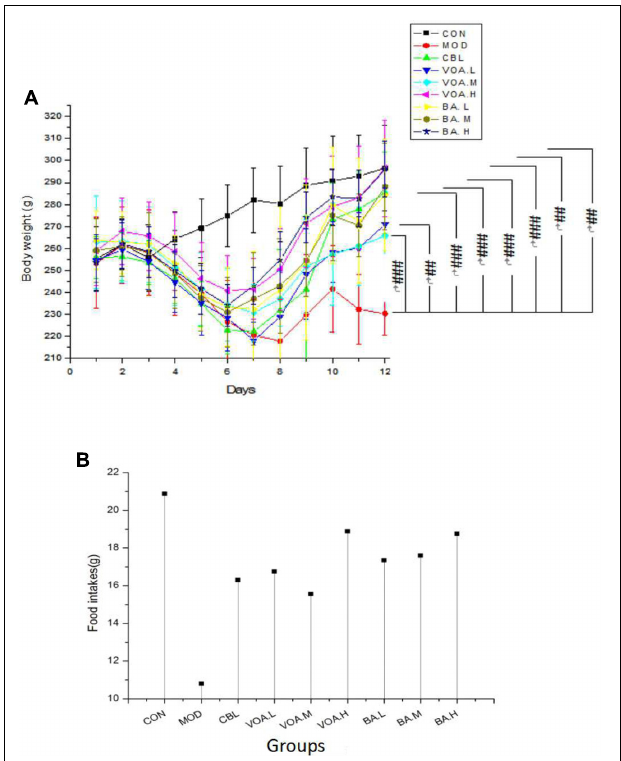
FIGURE 3 | Weight changes (A) and mean food intake (B) across groups. Data were recorded daily, # significant difference compared to the model and controls at the end of the study. # p < 0.05, ## p < 0.01, and ### p < 0.001.